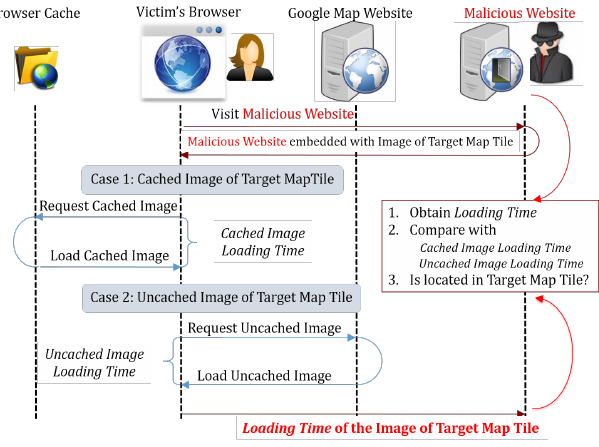
Figure 6. Web caching-based timing probing attack.